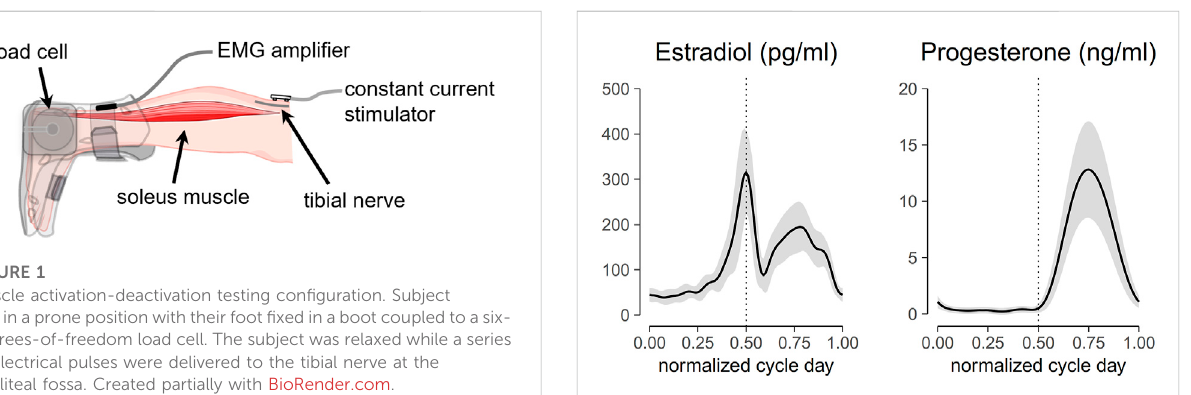
FIGURE 2 Aligned hormonal pro fi les from ovulatory cycles of the 22subjects testedinthestudy.Serumwascollected for measurement every other day for one cycle. The cycle day was normalized to cycle length and centeredatpeak estradiol concentration. Normalized cycleday0correspondstothe fi rstdayofmenses,0.5 correspondsto the peak of estradiol concentration, 0.75 corresponds to the peak of progesteronelevels,and1correspondstothelastdayofthecycle.The solid line represents the mean of all subjects, and the ribbon represents the standard deviation. Mid-cycle is marked with a dashed vertical